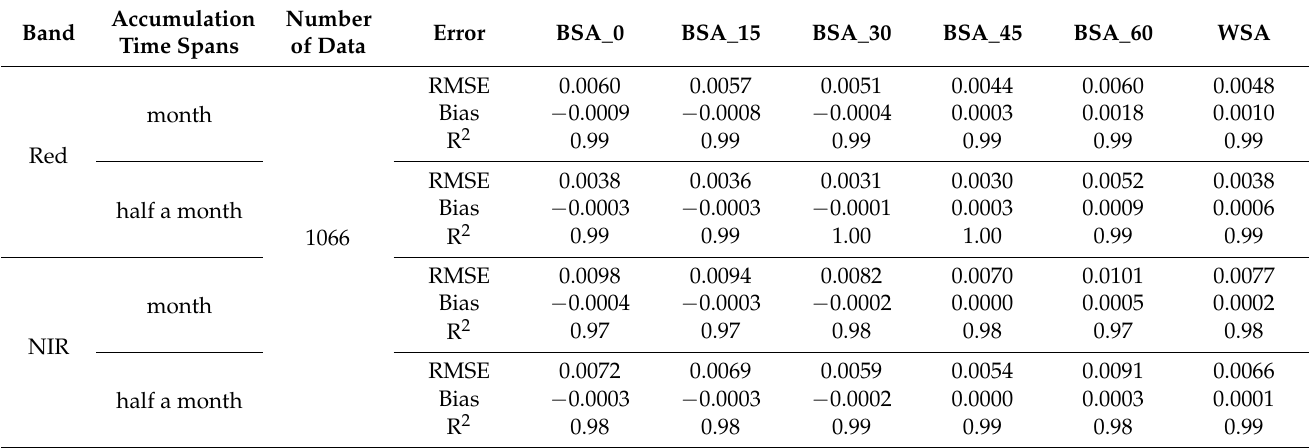
Table 10. Discrepancies in the retrieved albedos between daily, half-month, and monthly accumu- lated high-quality AHI observations (number ≥ 7, WoD ≤ 2).